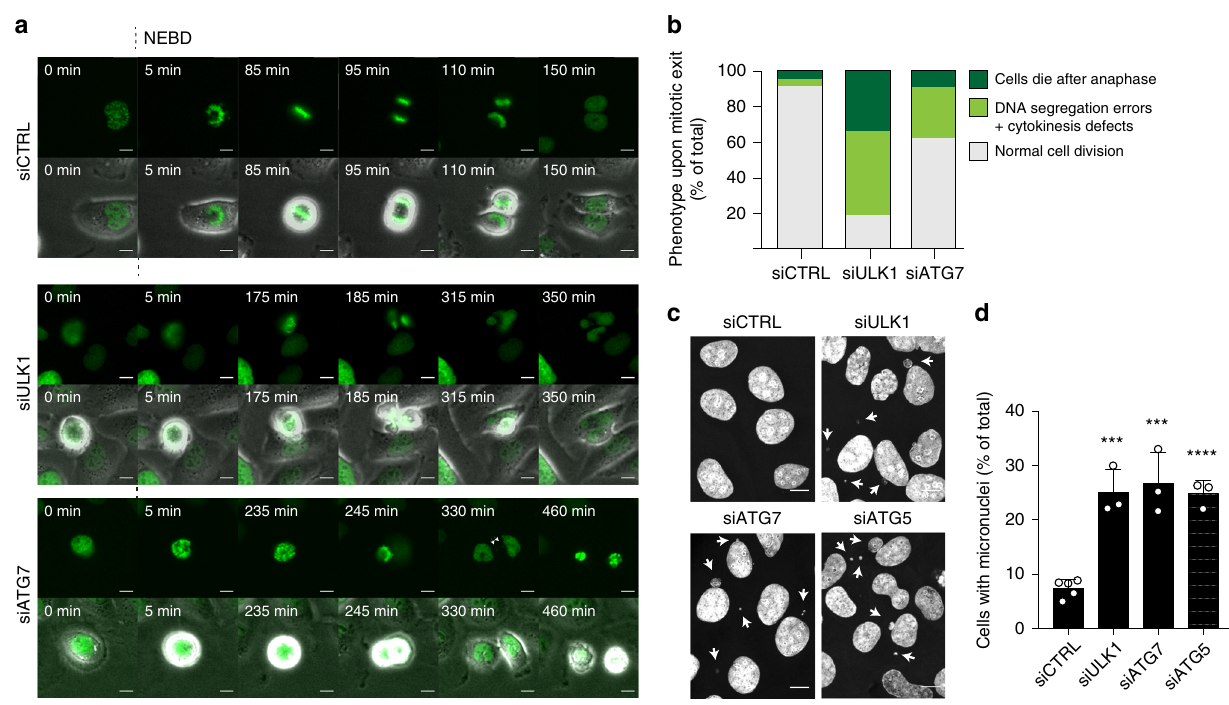
Fig. 2 Autophagy de fi ciency leads to chromosome segregation defects and postmitotic cell death. a Time-lapse imaging experiments of stable U2OS mRFP- α -tubulin H2B-GFP cells transfected with control, ULK1 or ATG7 siRNAs. GFP and DIC channels were recorded. Time-points after NEBD are indicated. b Quanti fi cation of phenotype distribution shown in ( a ). SCR, n = 169; ULK1, n = 47; ATG7 n = 179. c Representative immuno fl uorescence images of Hoechst33342-stained U2OS cells treated with control, ULK1, ATG7 or ATG5 siRNA for micronuclei quanti fi cation. Arrows indicate micronuclei. d Quanti fi cation of experiments shown in ( c ). Columns represent the mean ± SD, n = 3 ≥ 100 cells, ** P ≤ 0.01, *** P ≤ 0.001. Unpaired Student ’ s t -test, two- tailed. Scale bars, 10 µ m. Source data are provided as a Source Data fi